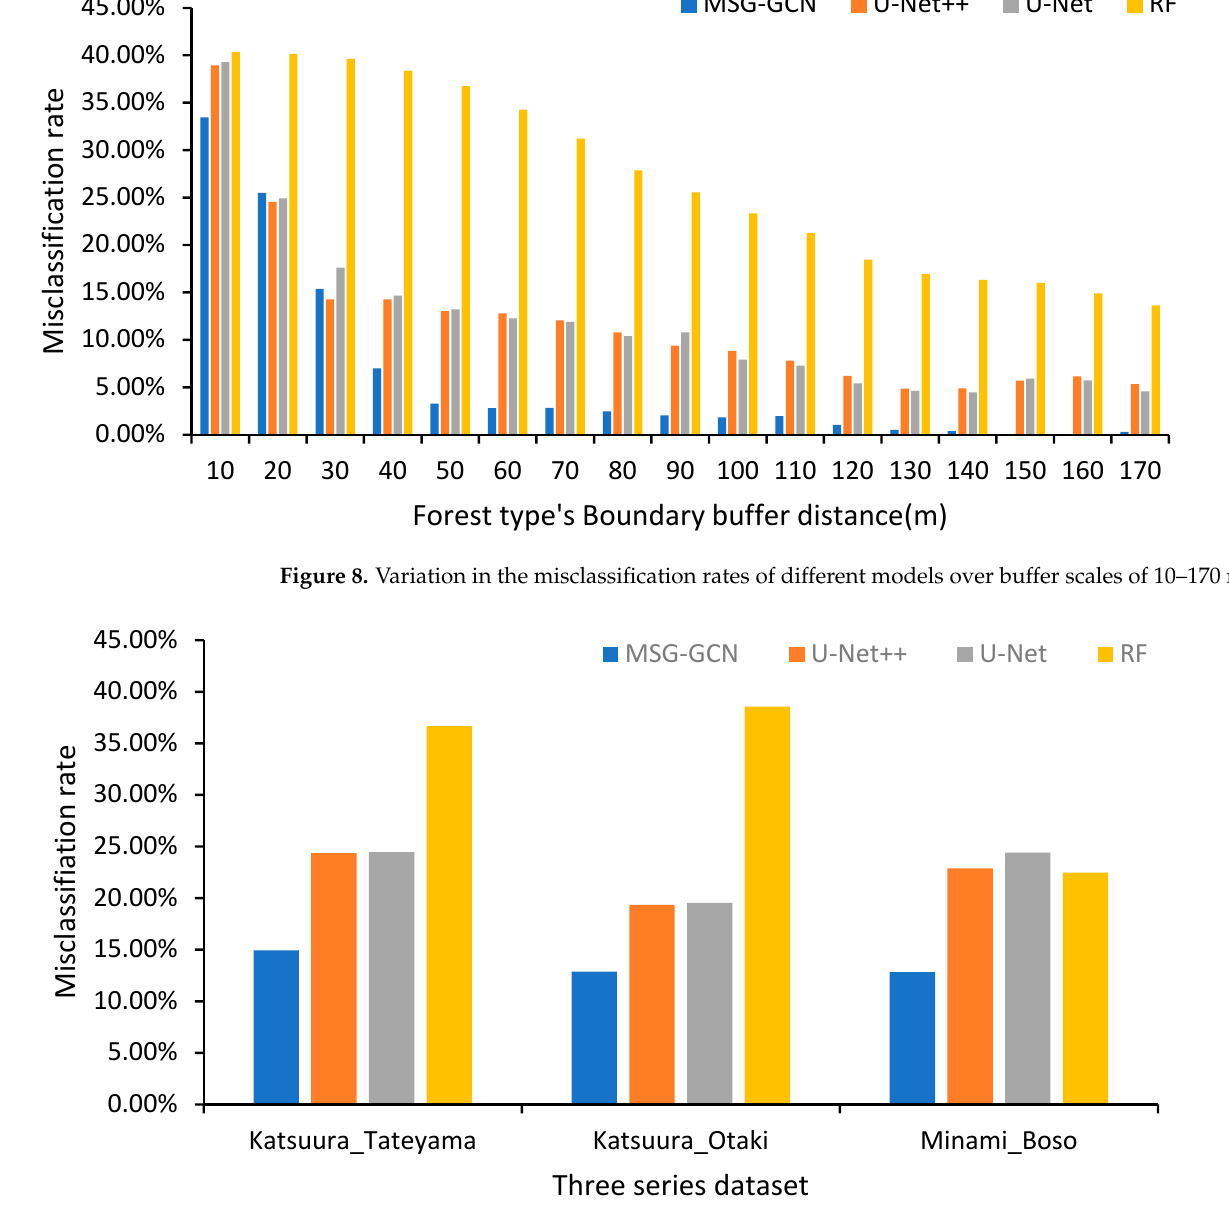
Figure 9. Misclassification rates for the different districts of all models.